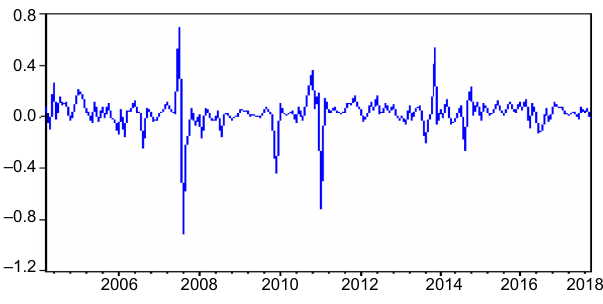
Figure 4. Dynamic conditional correlation between Google search